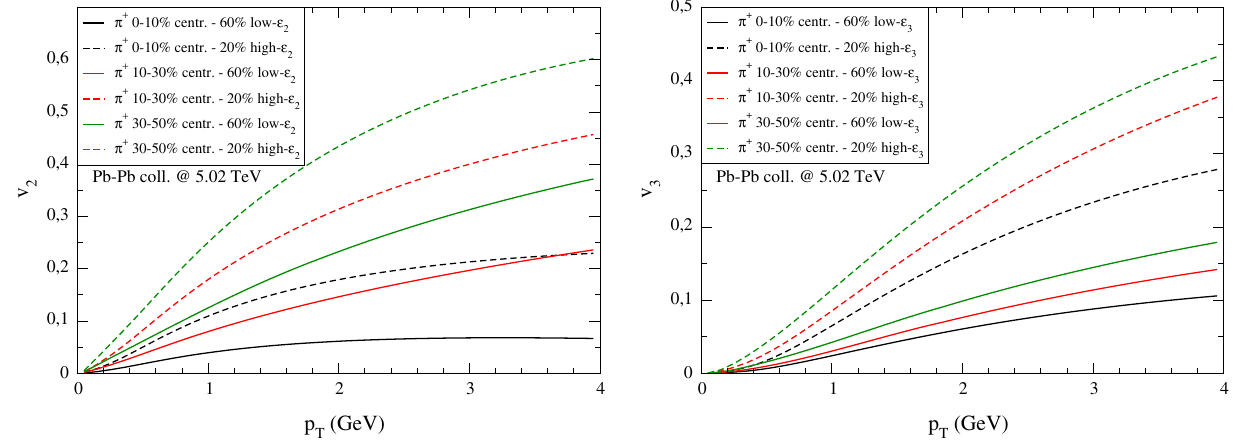
√ s NN = 5 . 02 TeV for different eccentricity